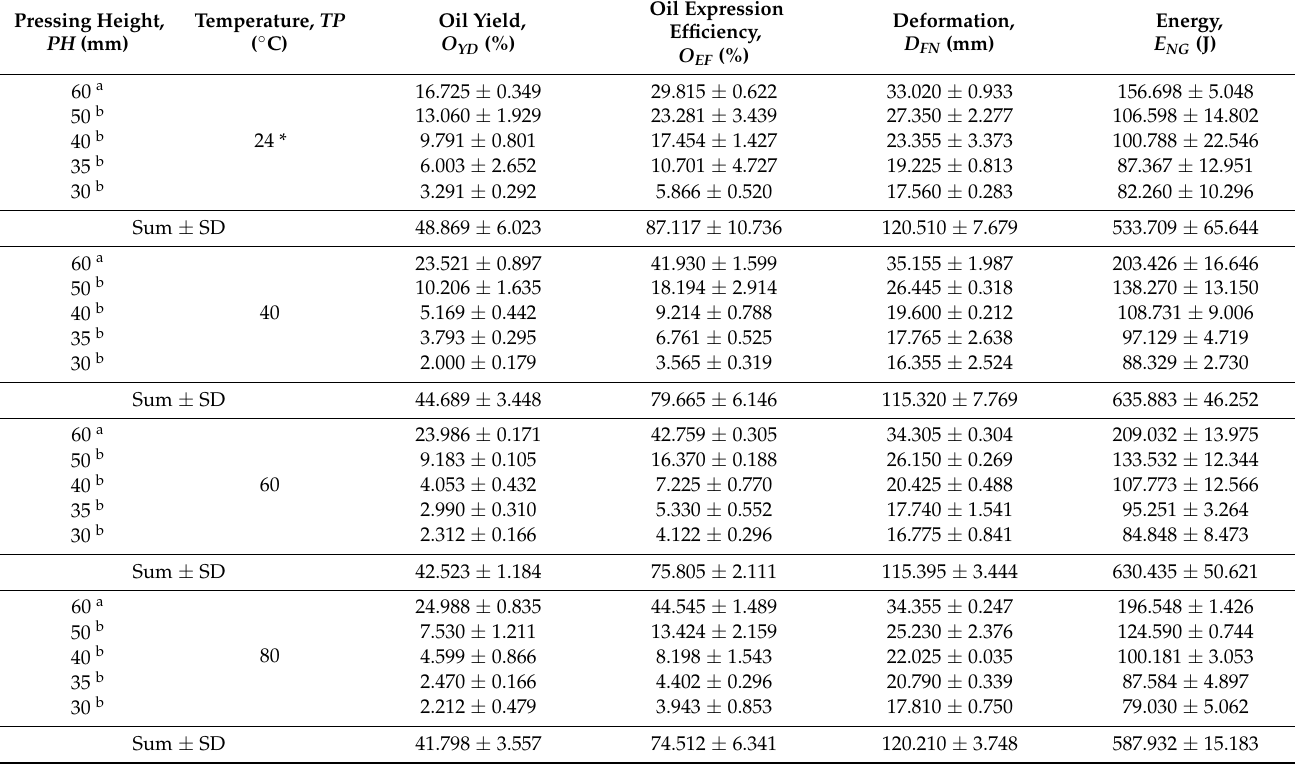
Table 1. Calculated parameters from the repeated pressings of hulled sunflower seeds